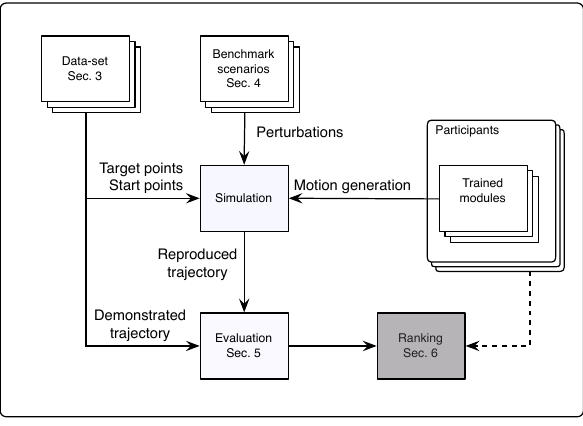
Figure 1: Schematic illustration of the benchmark